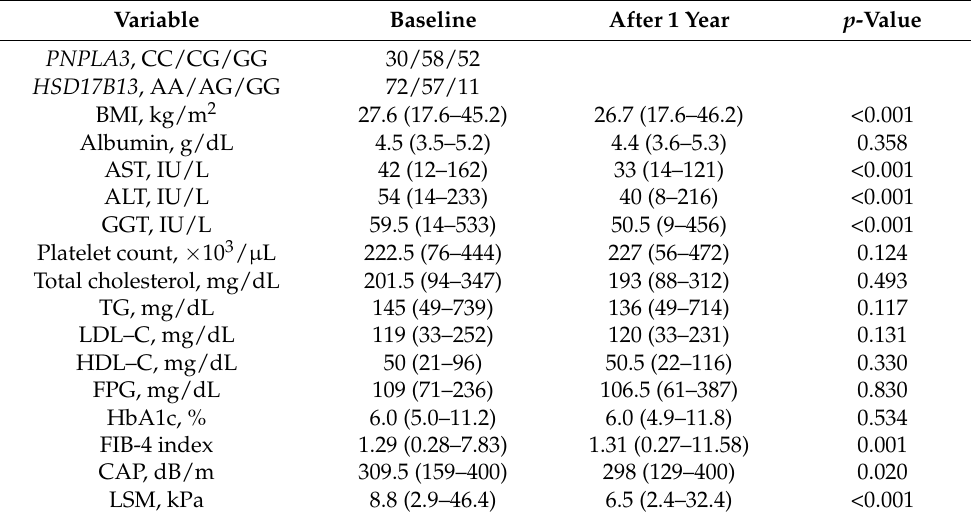
Table 3. The characteristics of 140 patients with nonalcoholic fatty liver disease at baseline and after 1 year diet